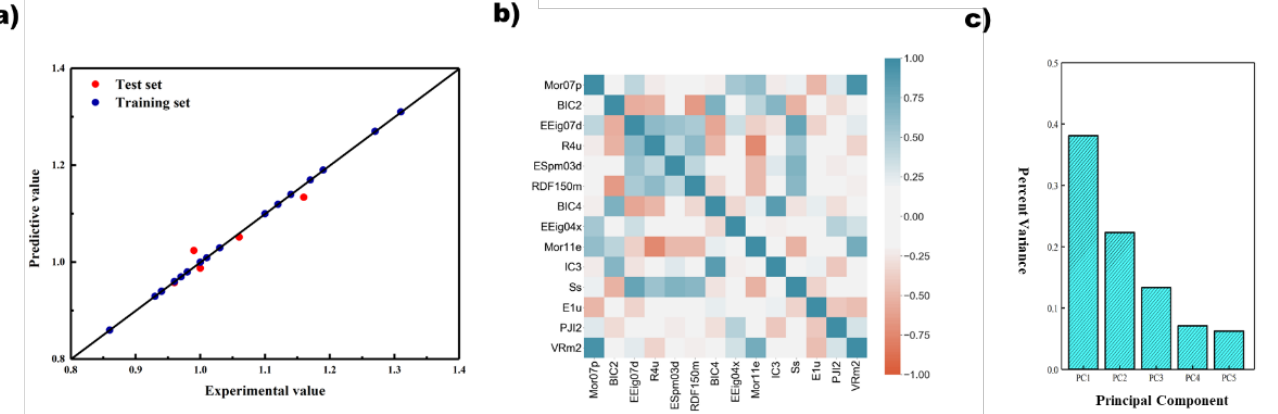
Figure 6. Results of the regression model based on GA-REC + PCA + SVR. ( a ) Prediction results; ( b ) correlation of descriptors; ( c ) principal component results.